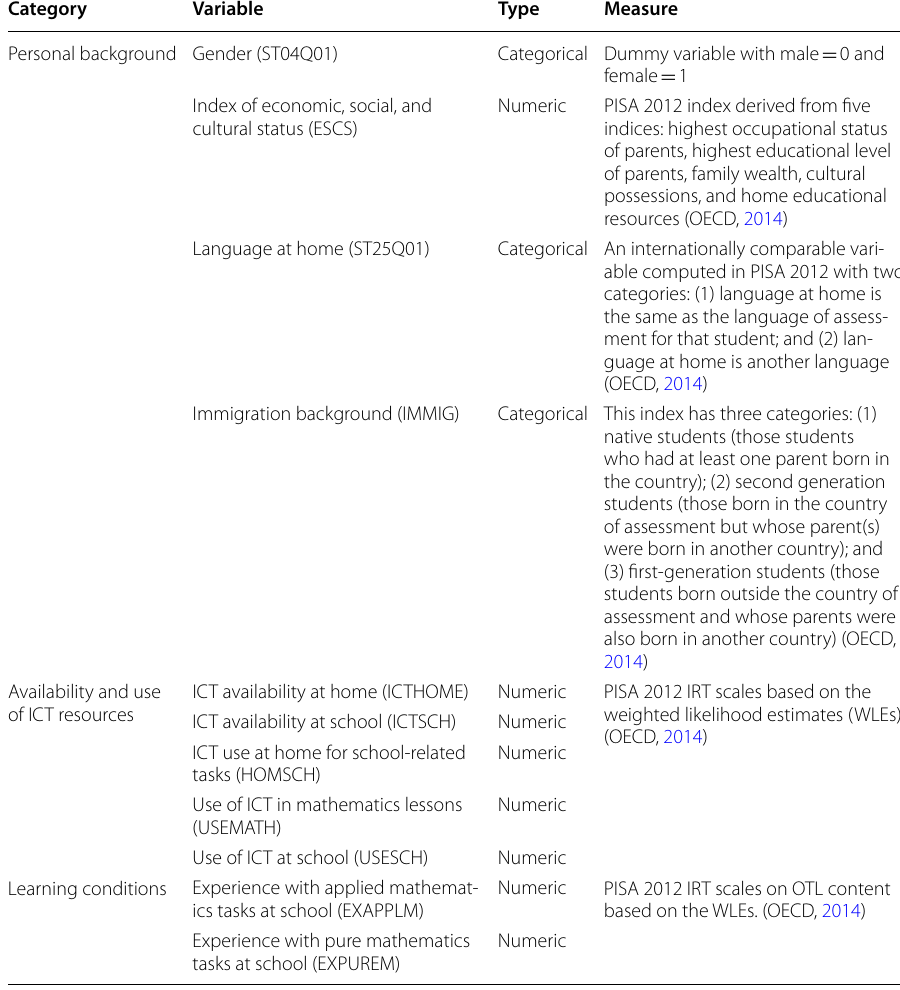
Table 3 Contextual variables extracted from PISA 2012 students’ questionnaires